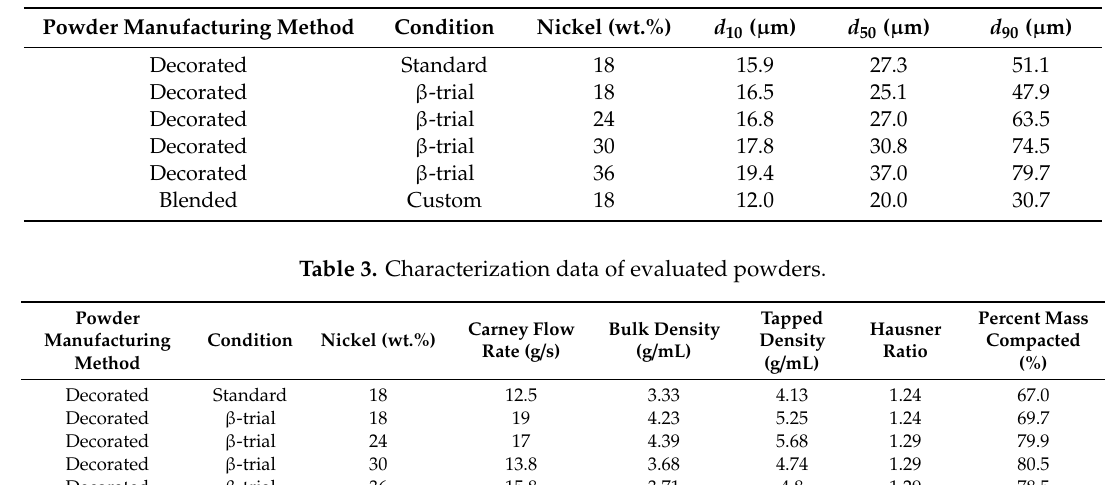
Table 2. Particle size distribution of evaluated powders.